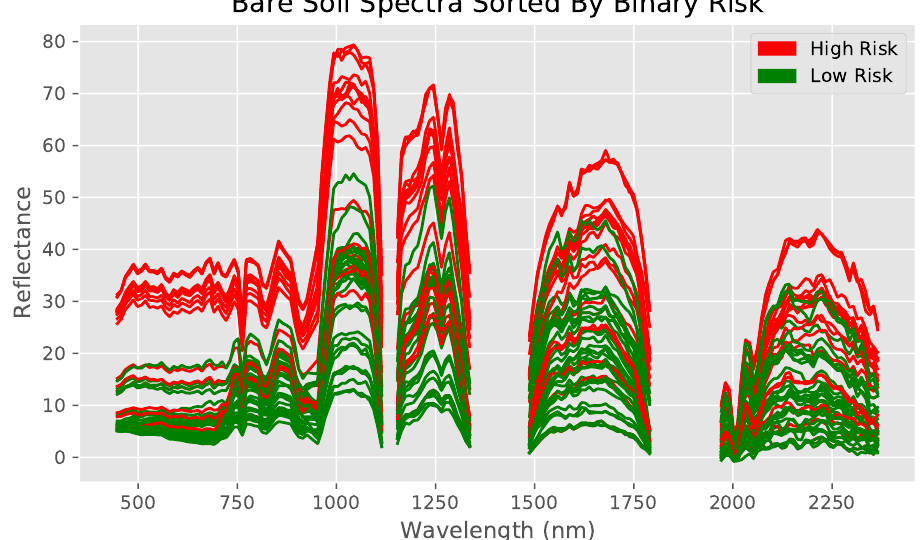
Figure 4. Hyperspectral data measured by EO-1 Hyperion, with bare soil spectra sorted into low and high risk regions. Spectra for each of the two classes visually differ clearly across the whole spectrum of wavelengths between 400 nm and 2400 nm. High risk is defined as the 70th percentile (7.0 mg/kg) and